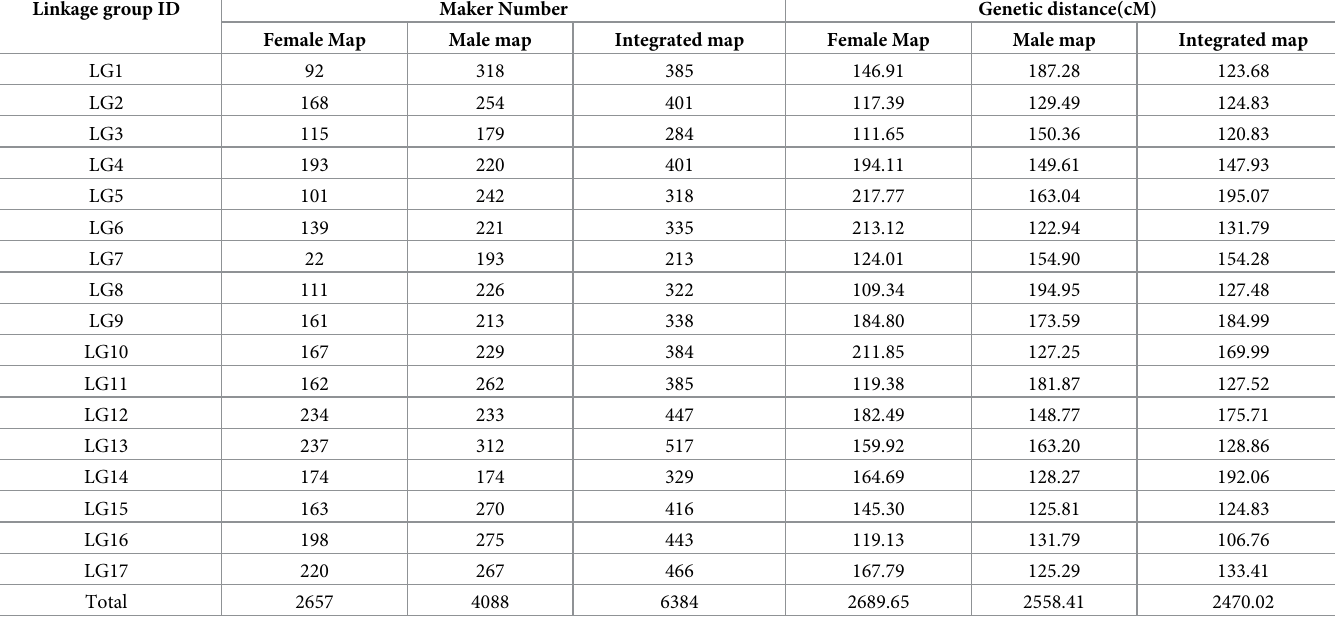
distance of adjacent markers ranged from 0.60 to 5.91 cM. The percentage of Gap � 5cM in 17 linkage groups ranged between 55.00% and 97.87% (Table 3, S1 Fig). A total of 4088 SNP markers (containing 1305 co-segregating markers and 483 marker bins) were anchored into 17 linkage groups of the male parent ‘Xinbinruanzi’ and the total Table 2. Marker distribution and total genetic length of 17 linkage